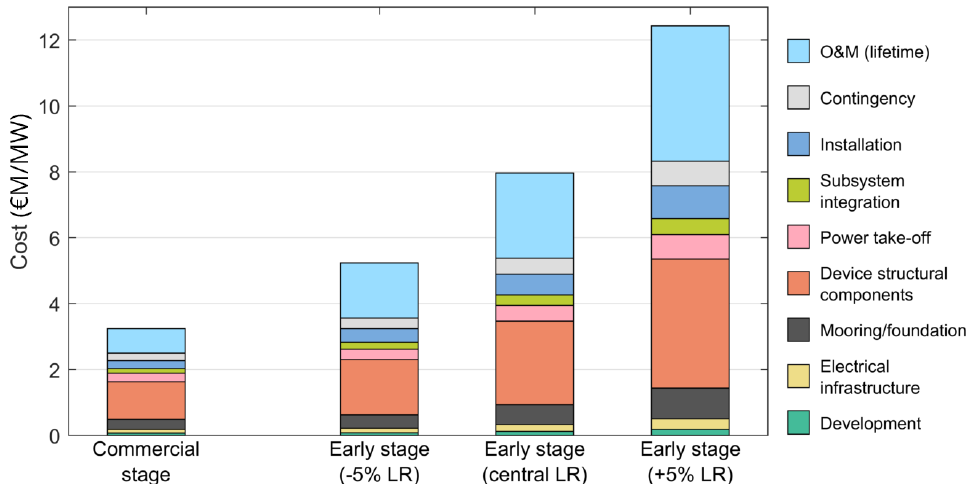
Figure 7. Results per cost centre for wave energy commercial-stage and early-stage CAPEX.